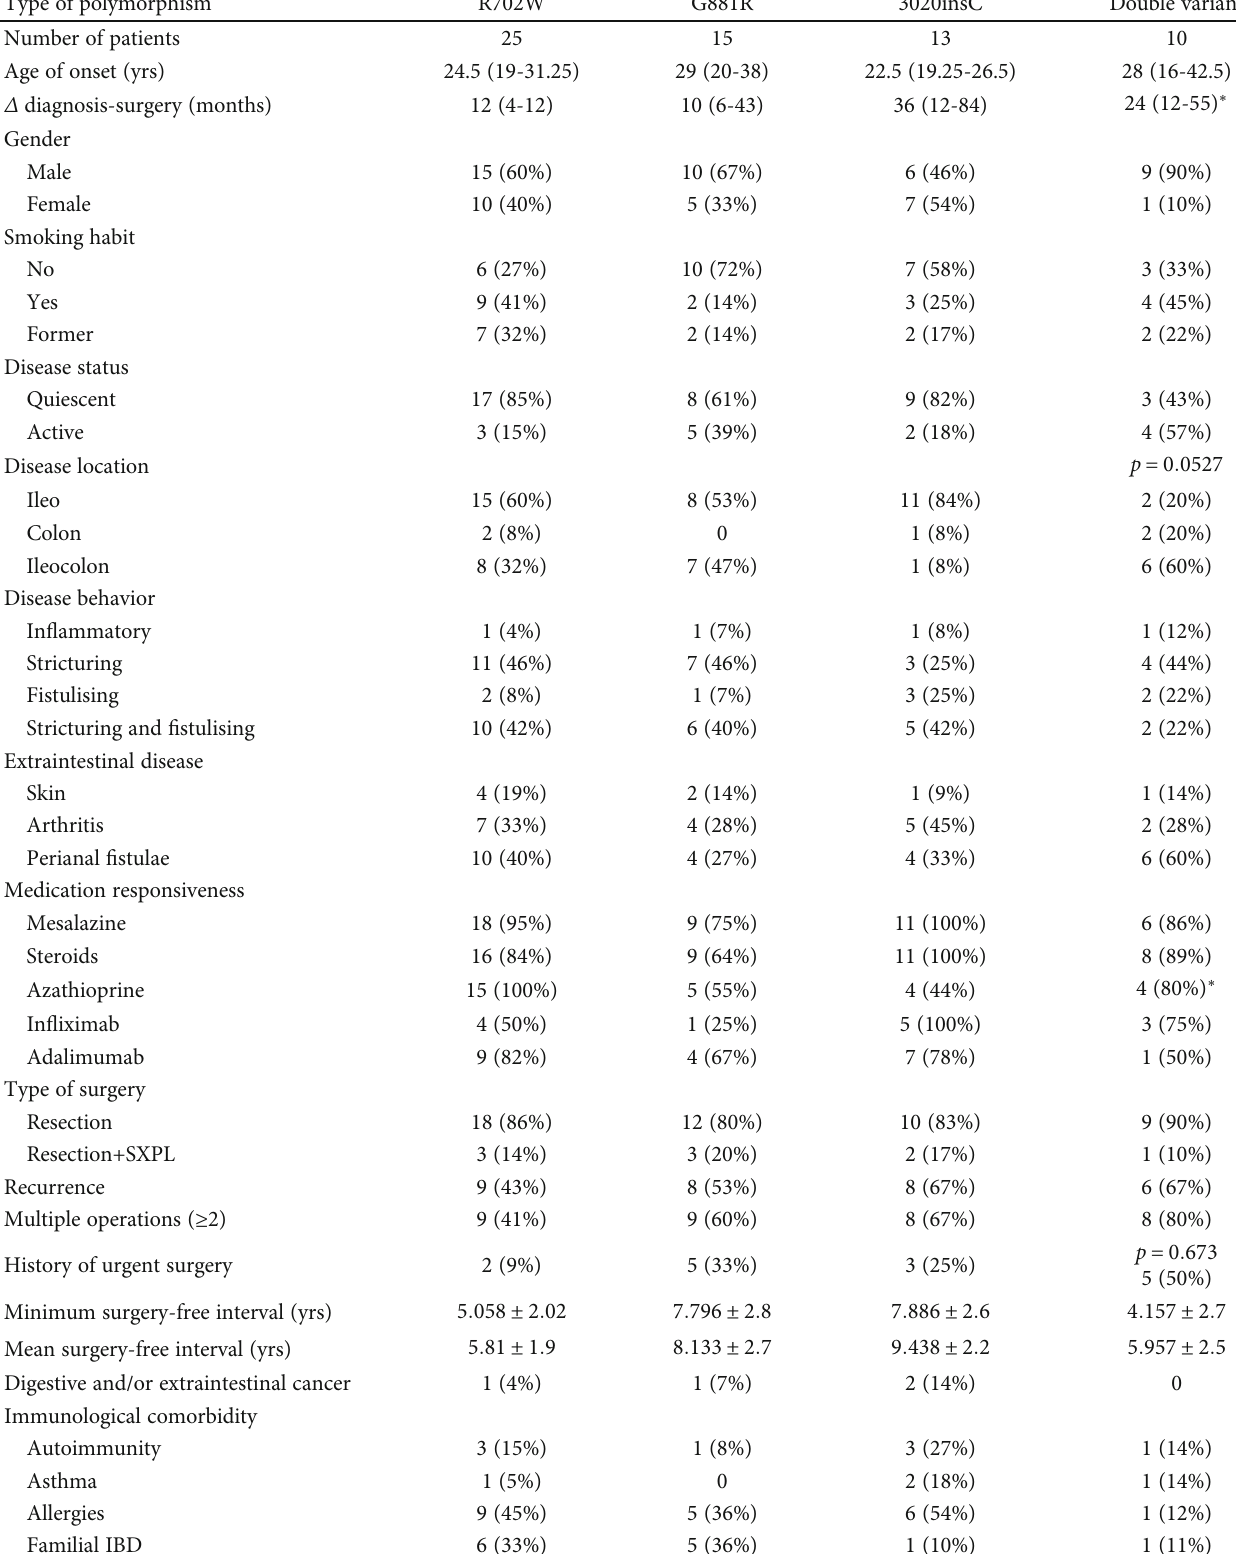
Table 3: Demographic and clinical features of polymorphism